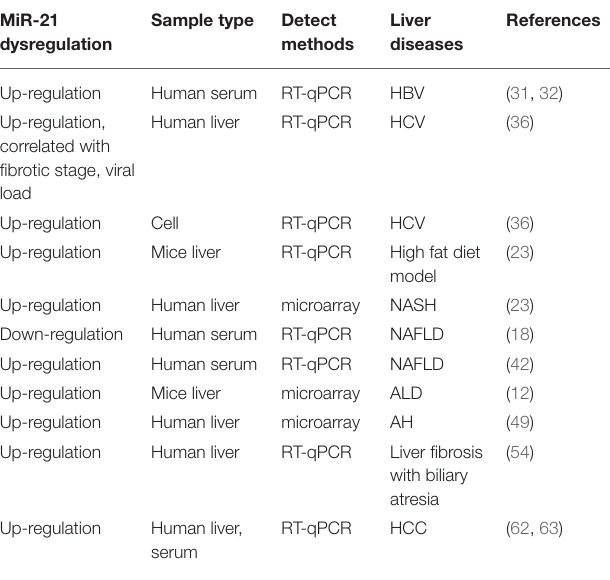
TABLE 2 | Summary of miRNA-21 dysregulation in various liver